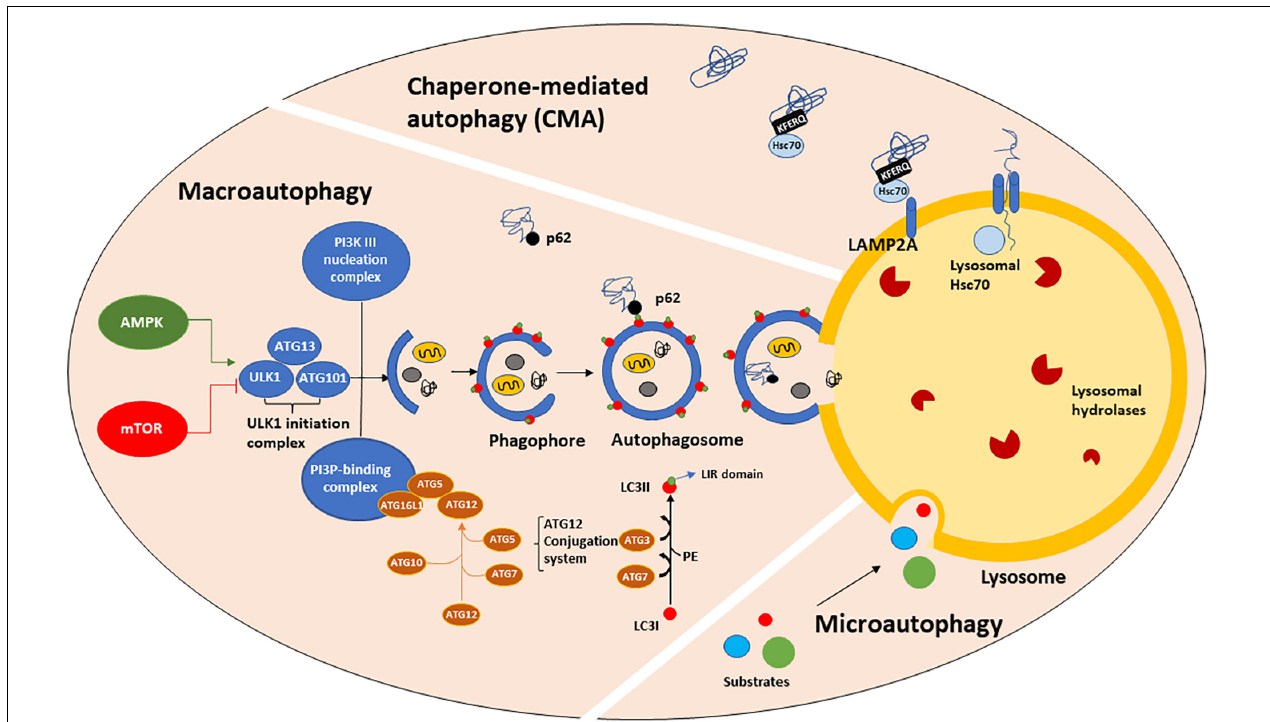
FIGURE 1 | The autophagic machinery. Three types of autophagy have been described: macroautophagy (henceforth referred to as autophagy), chaperone-mediated autophagy (CMA) and microautophagy. Autophagy is positively regulated by AMPK and negatively by mTORC1 which, in turn phosphorylates and mediates ULK1-initiation complex association and activation. The ATGs protein family, organized in three major complexes (the ULK1-initiation complex, PI3K III nucleation complex and PI3P-binding complex), mediates the formation of a cup-shaped membrane, termed phagophore. The phagophore directly engulfs a small portion of cytoplasm containing damaged organelles, misfolded or old proteins to form the autophagosome. Then, the autophagosome fuses with the lysosome, generating the autolysosome, in which autophagic substrates are degraded by lysosomal hydrolases activity and acidic environment. Substrate recognition and sequestration can also occur in a selective manner through intervention of LC3II. LC3I is a cytosolic protein, which after being conjugated to PE, translocates onto the phagophore membranes where it acts as a receptor for multiple cargo proteins, such as p62. p62 binds both LC3II (LIR domain) and ubiquitinated proteins (UBA domain), allowing their entry into the autophagosome for degradation. CMA is a one-by-one fashion type of autophagy and it is only referred to proteins bearing the KFERQ-like motif. Those proteins are directly recognized by cytosolic Hsc70, which shuttles them to the lysosomal membrane where it binds LAMP2A, a transmembrane receptor. The binding of Hsc70 to LAMP2A leads to its oligomerization, promoting the entry of CMA substrates into the lysosomal lumen. The presence of lysosomal Hsc70 is also required for cargo sequestration. Microautophagy is the least characterized form of autophagy. During microautophagy, substrates are directly engulfed by the lysosomal membrane, without an intermediate autophagosome